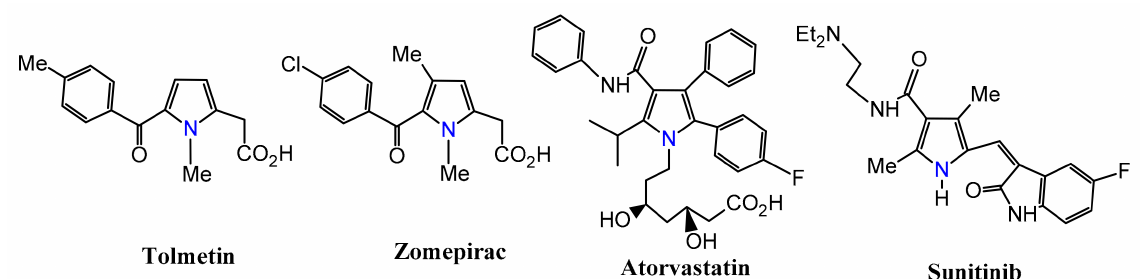
Figure 1. Structure of some pyrrole drugs.